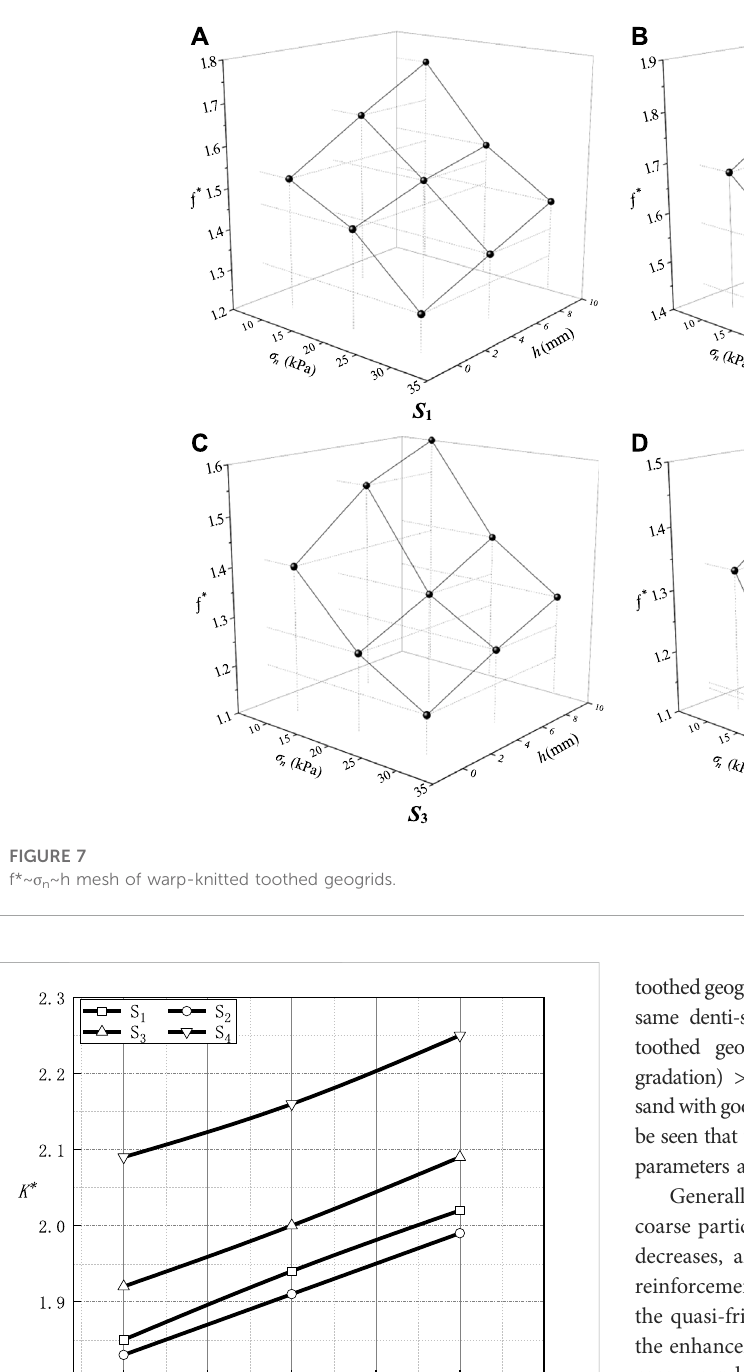
FIGURE 8 K*~h curve of warp-knitted toothed geogrids.